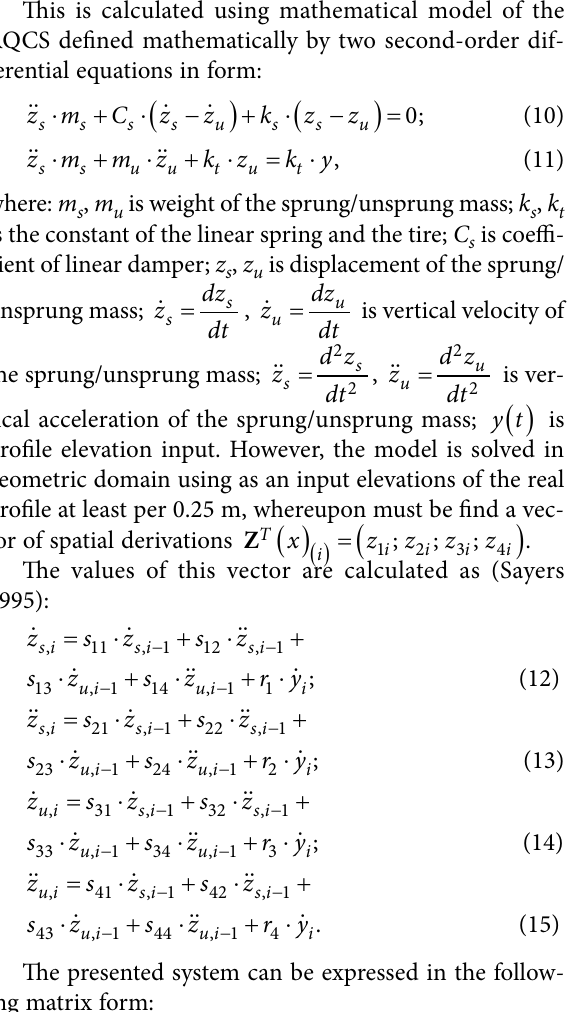
V = 80 km/hSprung mass m